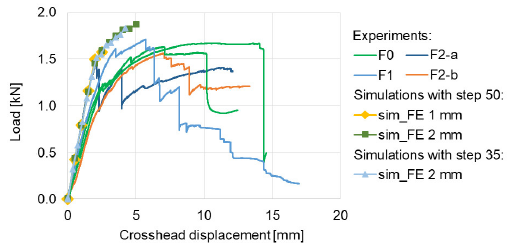
Figure 15. The effect of element size and load step size on calculated response in the CT test simulation with the pre-stress of 3 . 3 MPa, θ c = 0 . 4°, and failure type